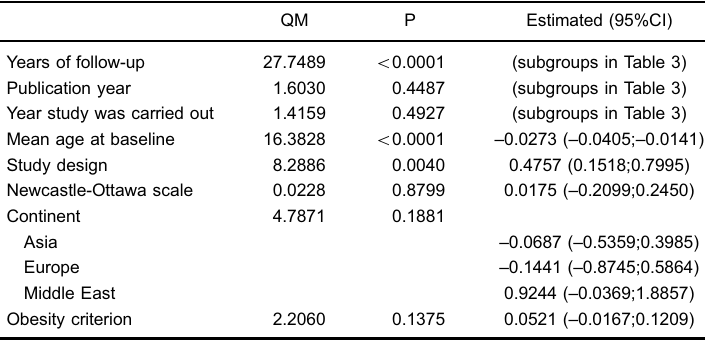
Table 2. Meta-regression results of the obesity-chronic kidney disease relationship.